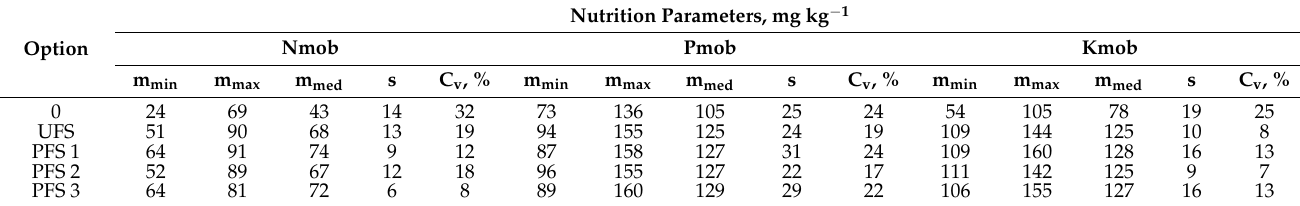
Table 3. Nutrient regime of the soil before sowing winter wheat.